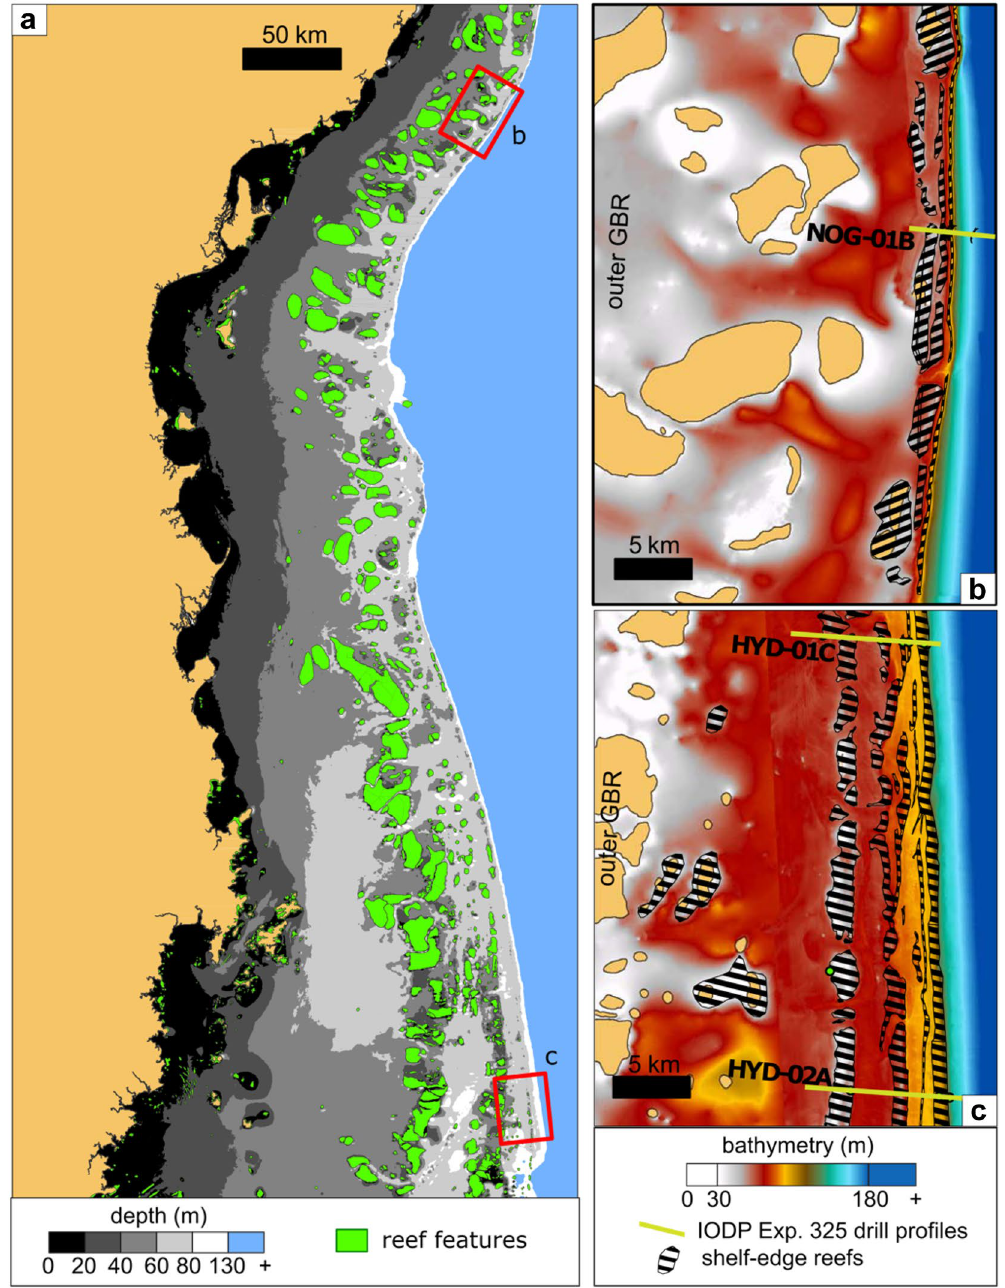
Figure 2. Central GBR and control zones: ( a ) Bathymetry of the central GBR with shallow reef presence map as interpreted from satellite imagery and bathymetric data 29 , and the locations of the control zones in the vicinity of Noggin Passage and Hydrographers Passage. ( b ) Noggin Passage in the northern central GBR has a narrower shelf edge reef area. ( c ) Hydrographer’s Passage in the southern central GBR. Note the reef area as estimated for the shelf edge and the location of the seismic and IODP Exp. 325 drilling transects NOG-01B, HYD-01C, HYD- 02A 30,40